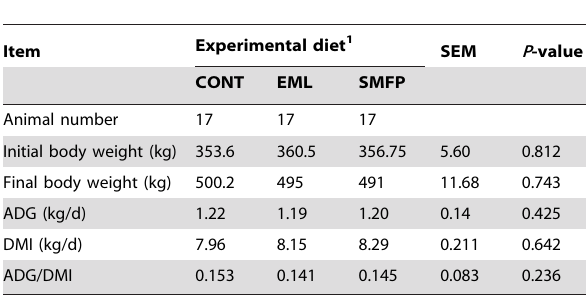
Table 2. Growth performance of finishing steers fed a total mixed ration supplemented with ensiled mulberry leaves (EML) or sun-dried mulberry fruit pomace (SMFP).